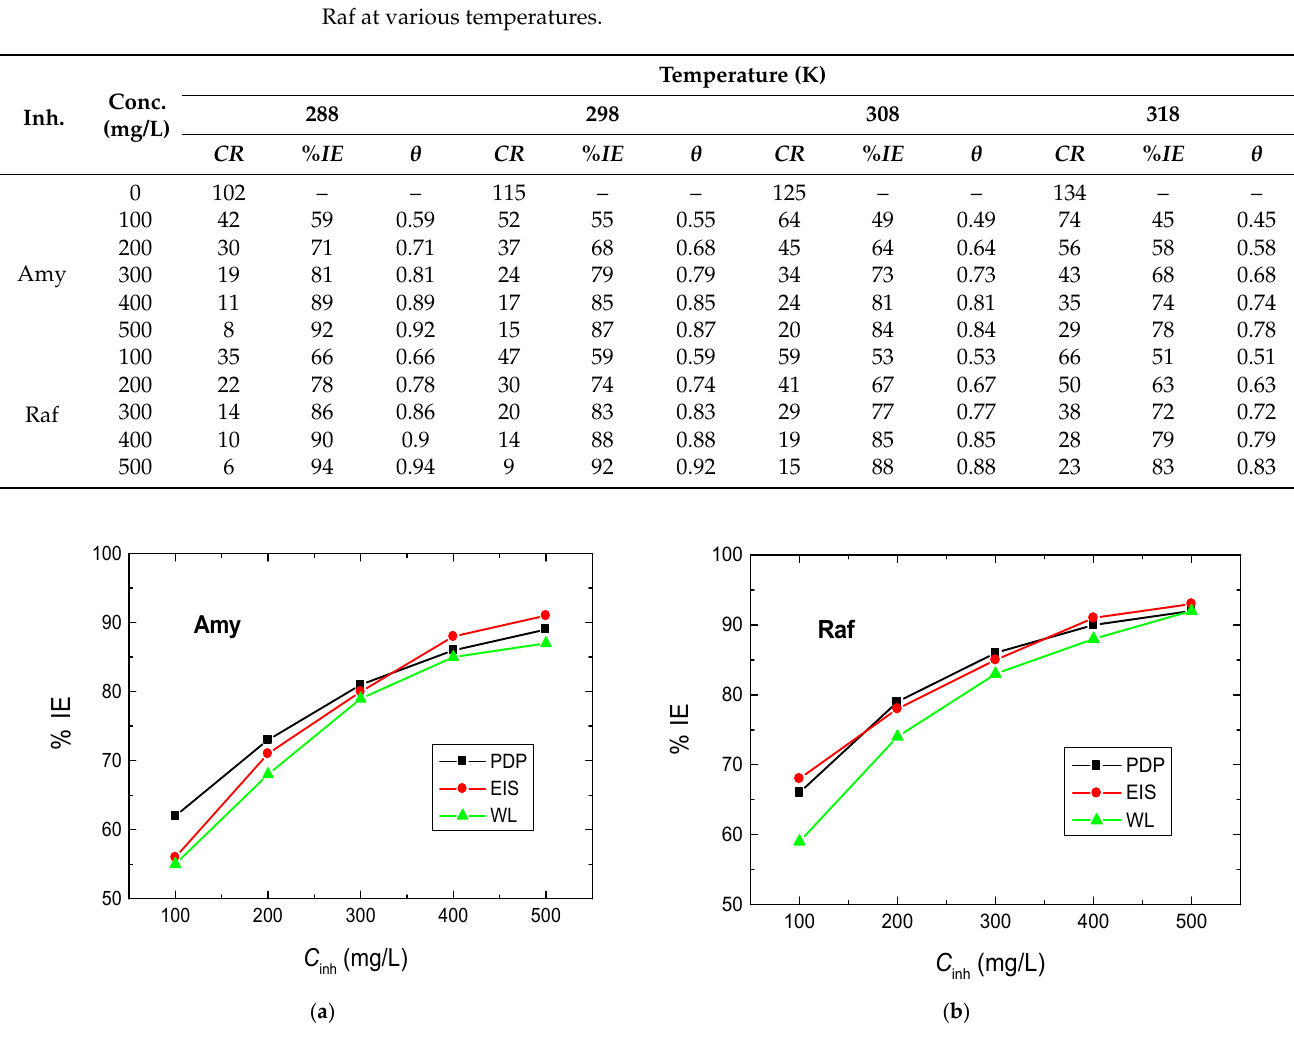
Figure 8. Variation of % IE s of, ( a ) Amygdalin (Amy), and ( b ) Raffinose (Raf), with their concentrations in the Al corrosion in 0.1 M NaOH medium using PDP, EIS, and WL techniques.